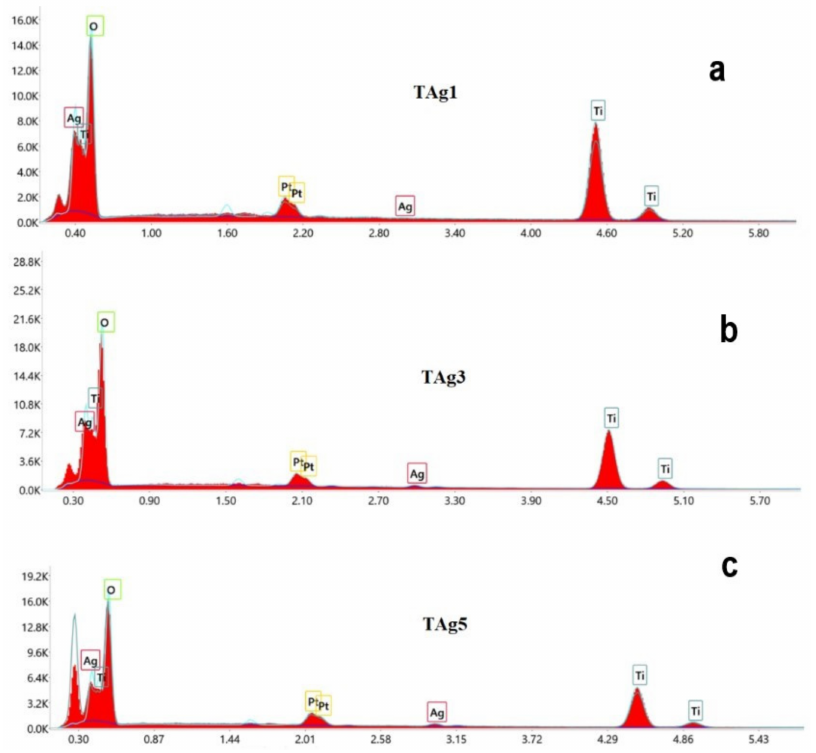
Figure 3. EDX spectra of 0.1% Ag–TiO 2 ( a ), 1.0% Ag–TiO 2 ( b ) and 5.0% Ag–TiO 2 ( c ). The EDX characterization confirmed the presence of Ti, O, Ag, and Pt elements. No other impurity elements were identified. The appearance of Pt in the EDS spectra is due to the sample’s preparation by Pt metallization for SEM/EDS measurements. The atomic percentages of Ag in the analyzed samples were found to be 0.05%, 0.21%, 0.40%,